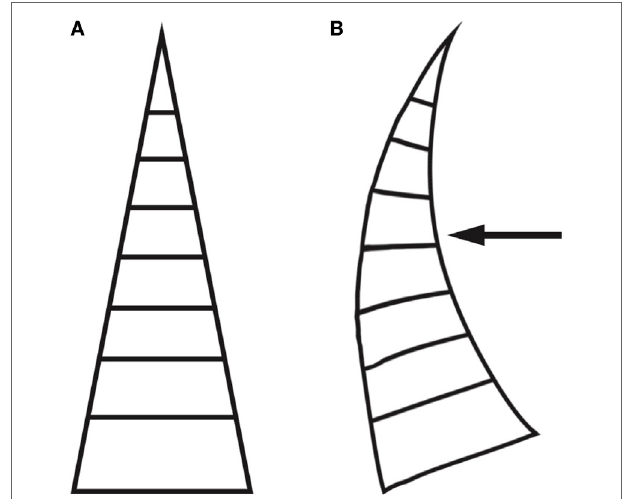
FigUre 1 | The Fin ray ® effect can be demonstrated by applying a force to the structure shown . The force causes the sides of the structure to bend, resulting in the base and tip deforming toward the applied load. (a) An unloaded Fin Ray ® structure. (B) A loaded Fin Ray ® structure.